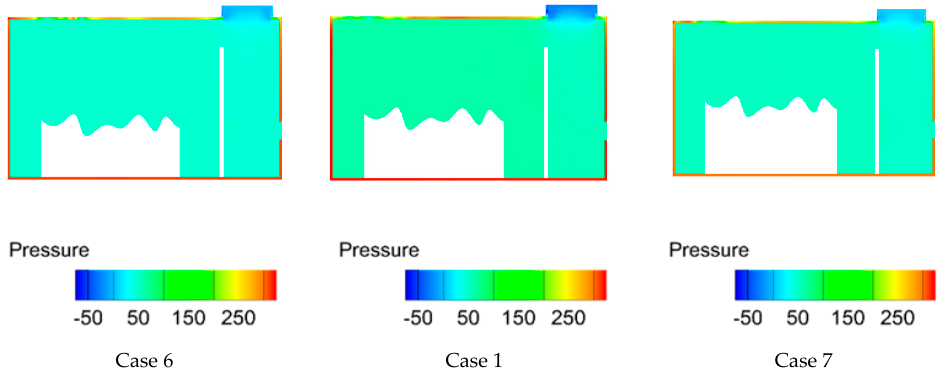
Figure 16. Total pressure inside the incinerator for the variations in waste volume (kPa).